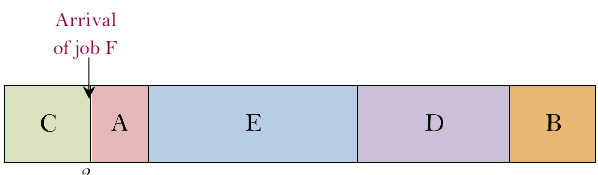
Figure 5. Disruption caused by job G arrival. Figure 4. Disruption caused by job F arrival.